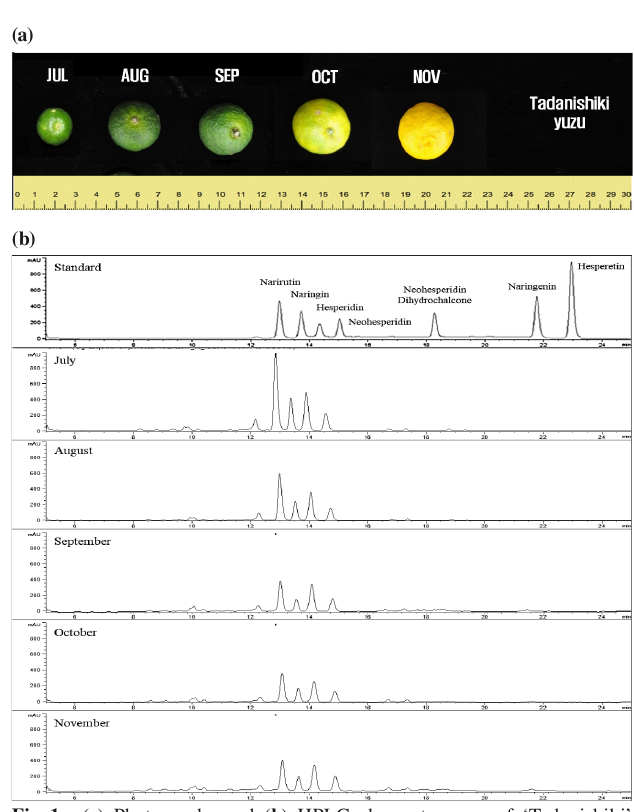
Fig. 1: ( a ) Photographs and ( b ) HPLC chromatograms of ‘Tadanishiki’ yuzu by harvesting period.